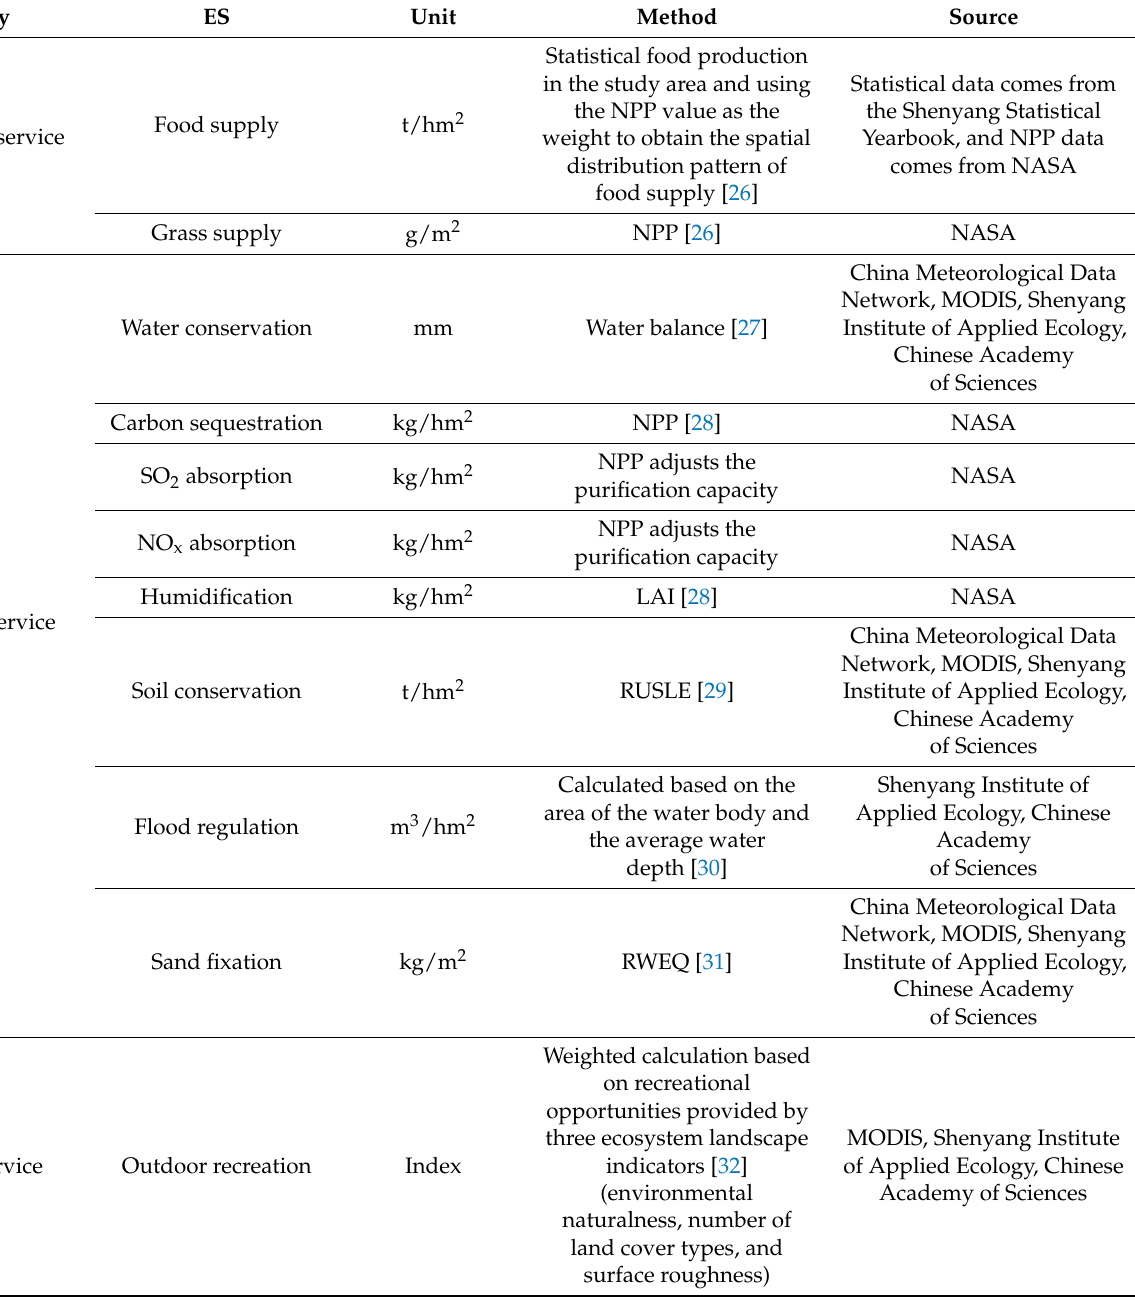
Table 1. Calculation methods and data sources of ecosystem